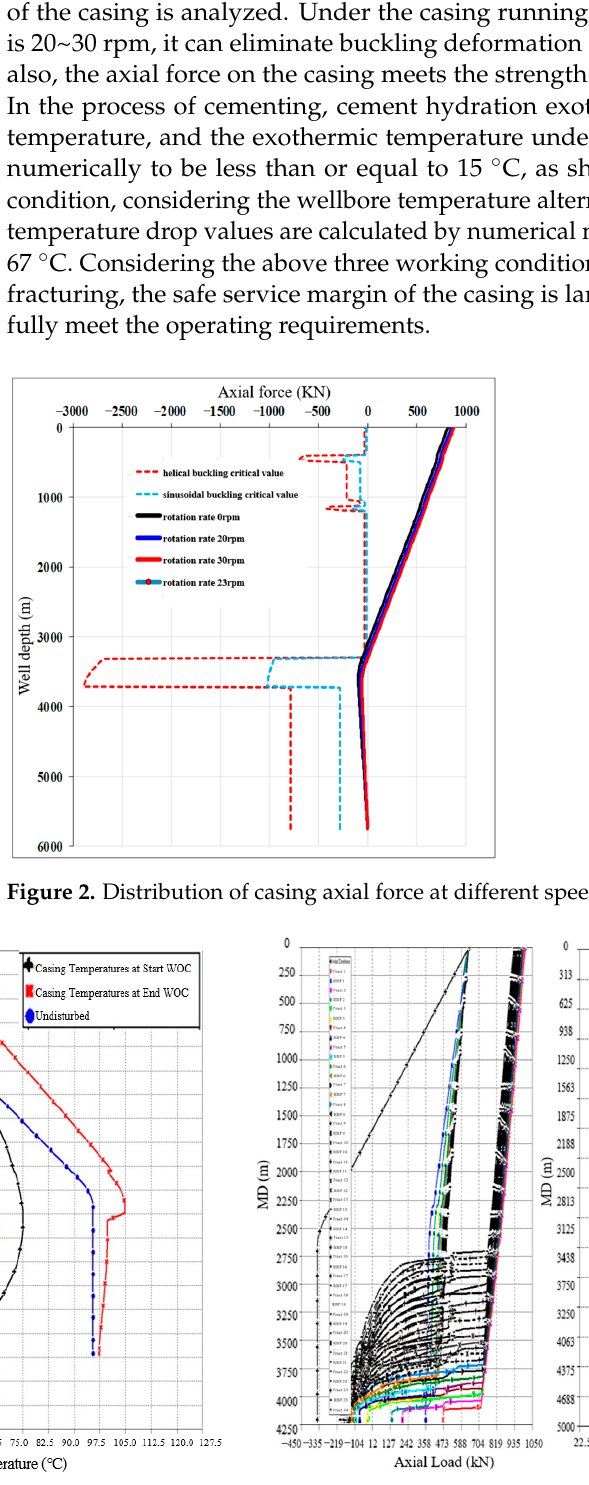
Figure 1. True stress–strain curves of P110 and Q125 casings.